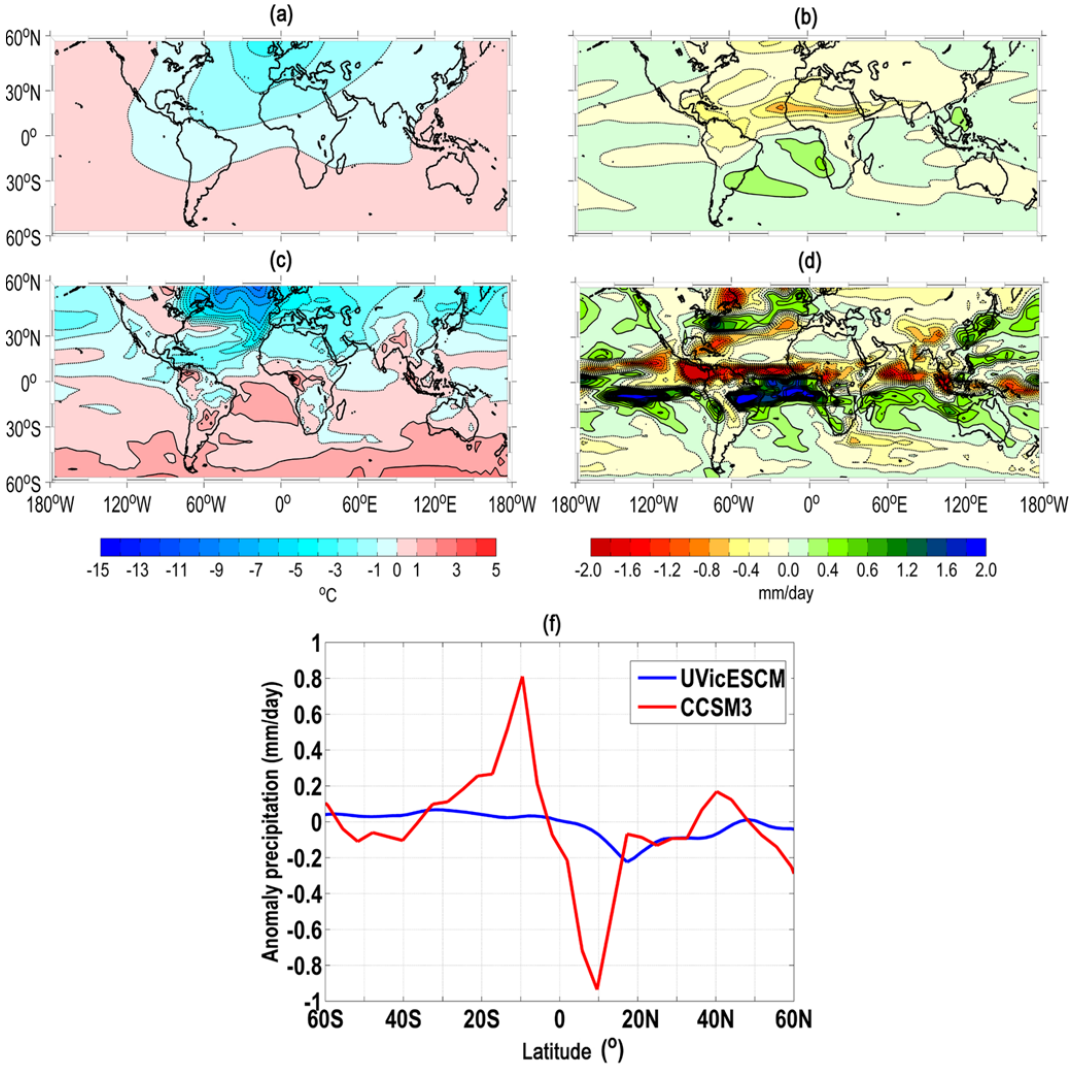
Fig. 1. Annual mean anomalies of surface temperature ( a and c ) and precipitation ( b and d ) between HE1 UVic and LGM UVic (top) and be- tween HE1 CCSM and LGM CCSM (middle) simulations. The contour intervals are fixed at 1 ◦ C for surface temperature and 0.5mmday − 1 for precipitation. (e) The global zonally averaged precipitation differences between HE1 and LGM simulations for the UVic ESCM (blue) and the CCSM3 model